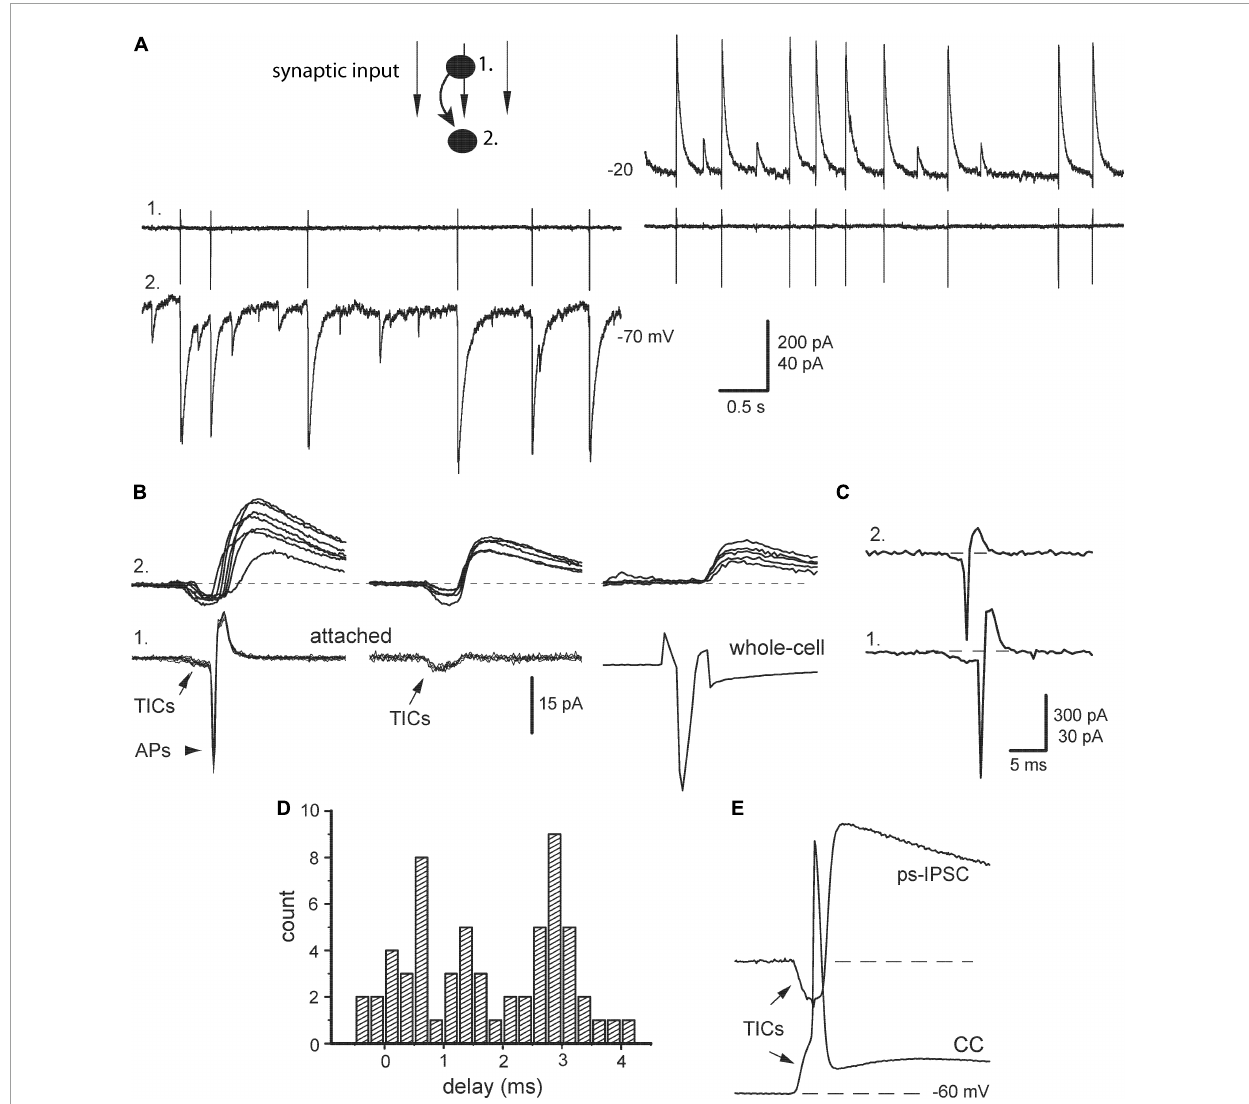
FIGURE4 Relation of post-stimulus sIPSCs with presynaptic action potentials. (A) Identification of synaptic output of a given presynaptic neuron (#1, cell-attached mode) within a raw post-stimulus sIPSCs impinging on postsynaptic neuron (#2, whole-cell mode) at indicated potentials. (B) Left , paired segments were aligned, respectively to presynaptic action potentials ( APs ) with preceding TICs. Middle , examples of APs failures and persisting TICs. Right , presynaptic IN was stimulated next in whole-cell mode. (C) An example of correlated APs in pair of INs. (D) Distribution of synaptic delays [taken from panel (A) ]. (E) An example of the paired segment with synchronous TICs when presynaptic IN was kept in current-clamp mode